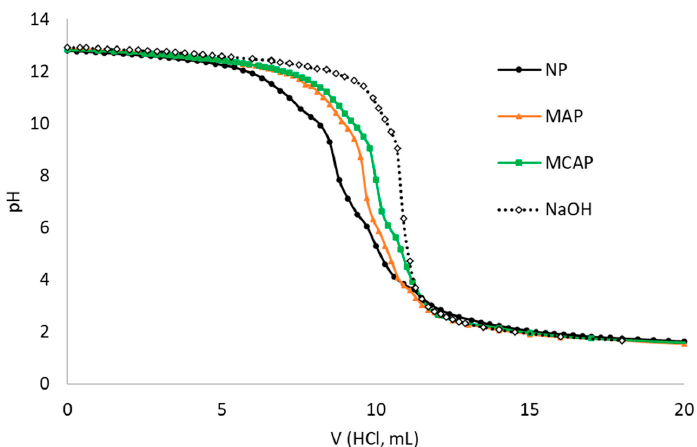
Figure 3. Determination of the total amount of charged groups in the peat moss samples by poten- tiomenric titration within the рН range of 2 ÷ 13. Table 4. The content of phenolic and carboxyl groups in the peat samples according to reverse po- tentiometric titration, mmol/g.